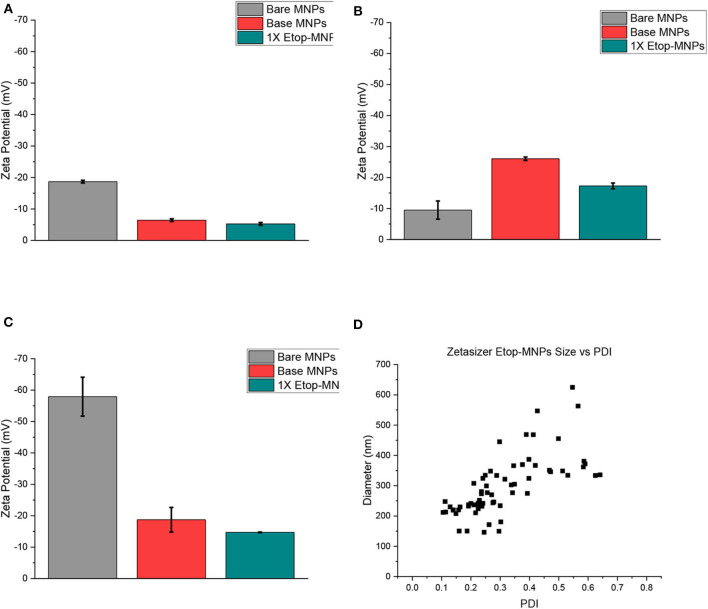
Analysis of MNP zeta potential and polydispersity. (A–C) Bar graphs of zeta potential data, obtained from the Malvern Zetasizer instrument for bare, base, and Etop-MNPs at 24 h in PBS (A), dH2O (B), and 10 mM NaP (C). (D) Scatter plots of polydispersity data, for Etop-MNPs. The polydispersity index (PDI) is shown along the x-axis, and aggregate diameter is shown along the y-axis. For (A–C), data are expressed as mean ± SEM with n = 3.